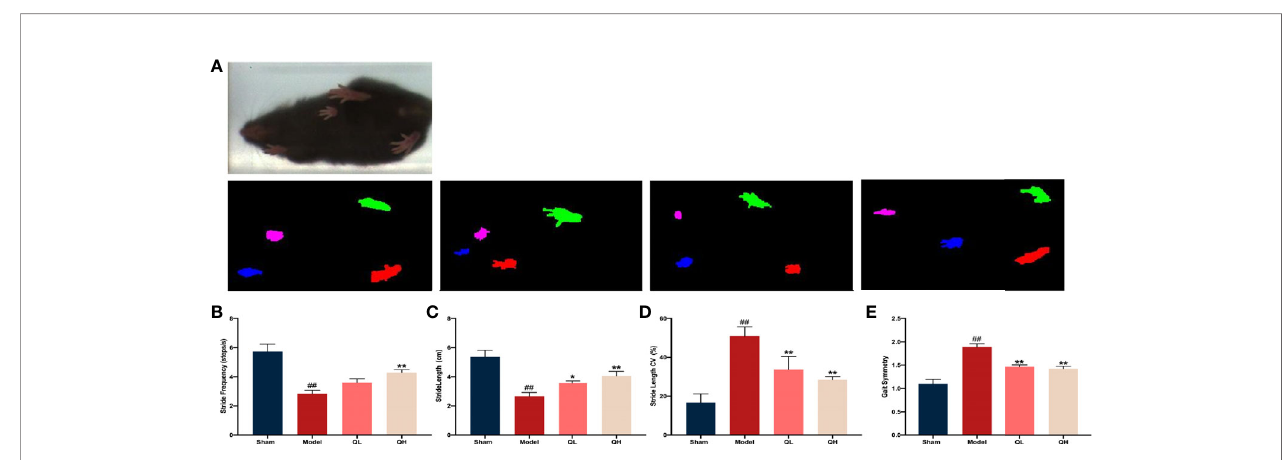
FIGURE 4 | Gait analysis in mice that underwent orchiectomy. (A) The full gait was recorded and segmented into independent gait cycles. Changes in gait characteristics: including the (B) stride length, (C) stride length CV, (D) stride frequency, and (E) gait symmetry. ## p< 0.01 vs. sham group; * p< 0.05, ** p< 0.01 vs. model